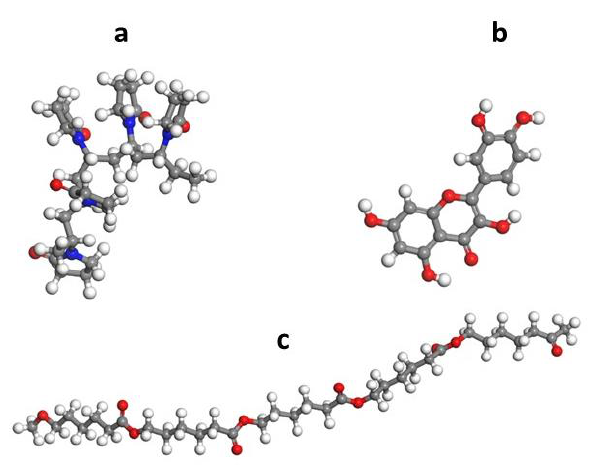
Figure 3. Optimized molecular structures of ( a ) PVP, ( b ) Quercetin and ( c ) PCL.